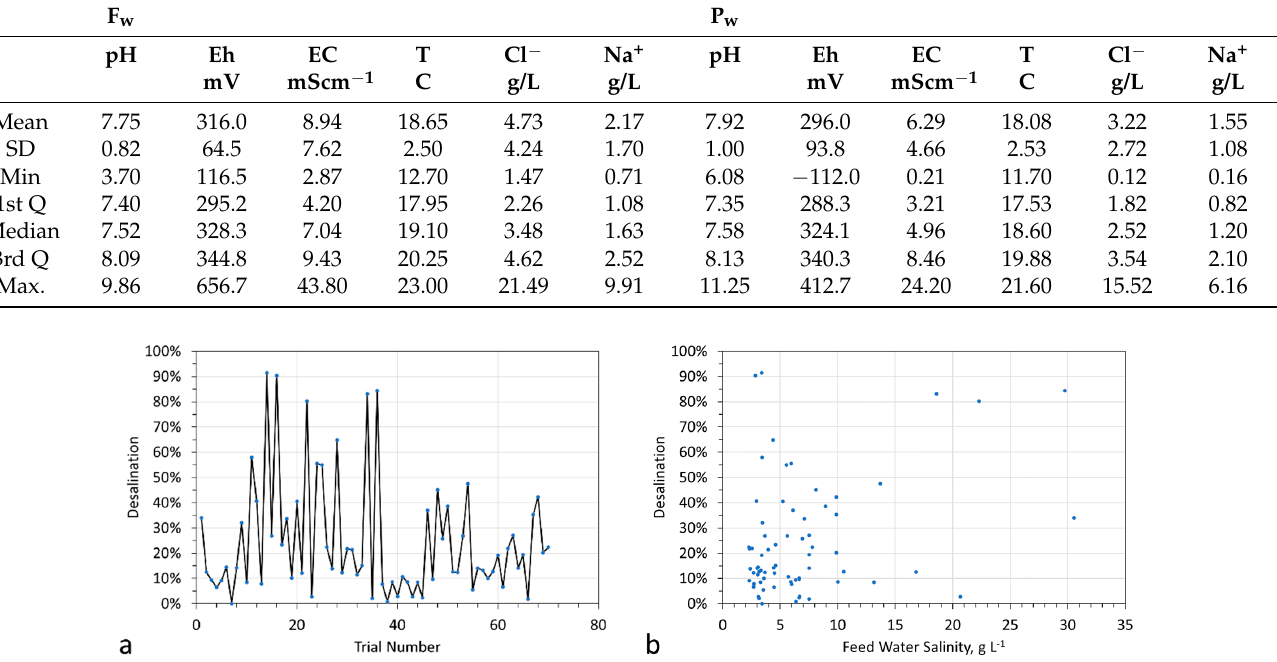
Figure 9. Desalination. ( a ) Desalination vs. trial number. ( b ) Desalination vs. feed water